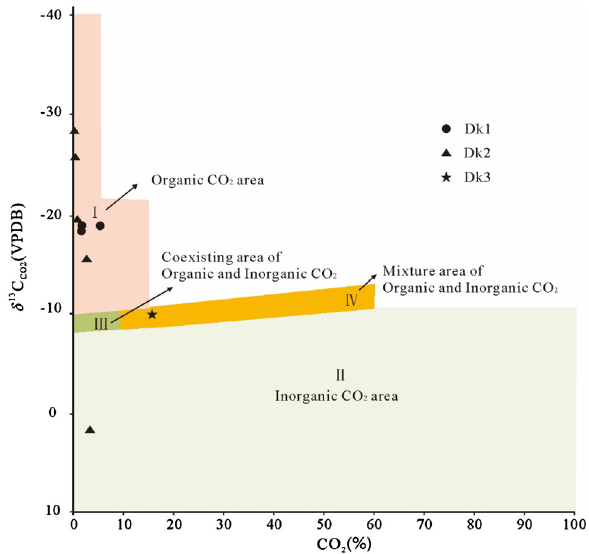
Fig. 6 Genetic types of carbon dioxide from gas hydrates in the Juhugeng Sag (after Dai and Li 1995)